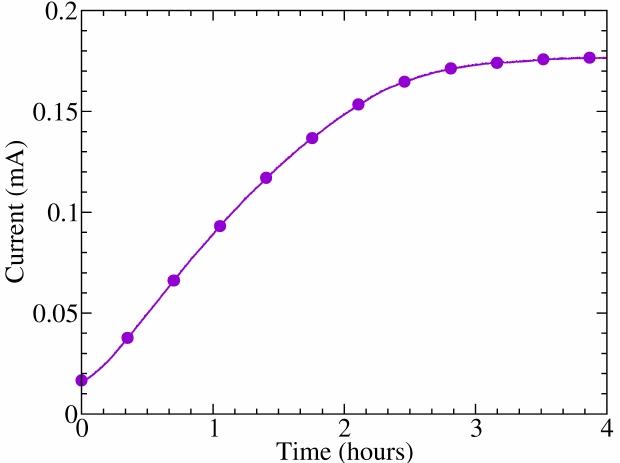
Figure 2. Dark current evolution of photodetector “10:20” after the introduction to the atmosphere from the